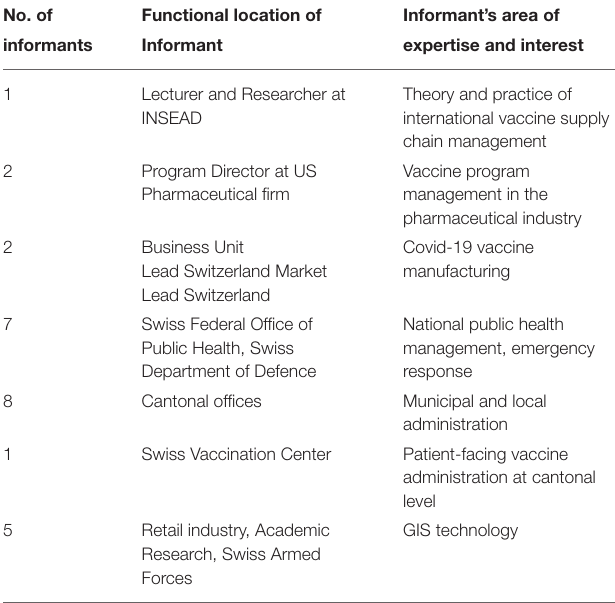
TABLE 2 | Key informants interviewed during the course of the study. No.